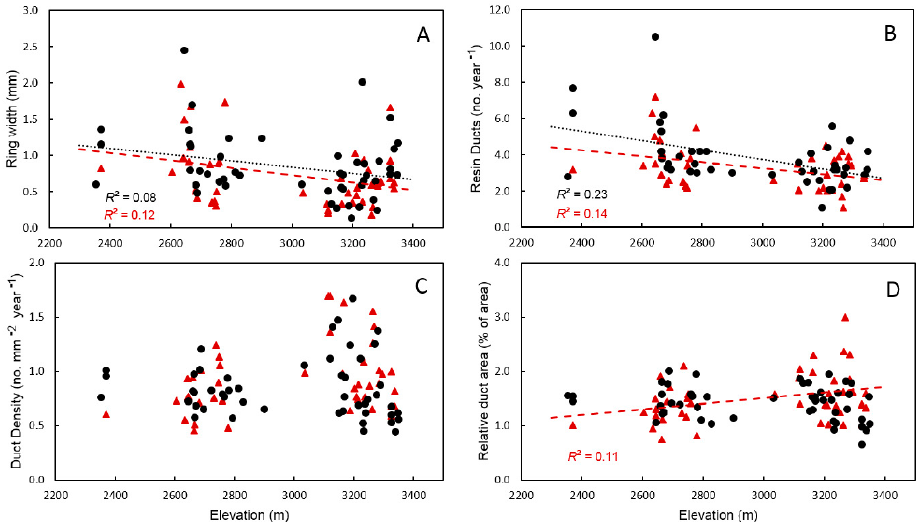
Figure 4. Limber pine vertical resin duct metrics averaged per year for the 10-year interval from 2001 to 2010 as a function of elevation. Radial growth ( A ) and resin duct production ( B ) significantly decreased with increasing source elevation. Duct density ( C ) was not significantly correlated with elevation and only relative duct area ( D ) of susceptible trees was significantly correlated with source elevation. All metrics were calculated using the extracted cores, not the entire tree stem. Symbols are as shown in Figure 3. Black circles are trees inferred in previous studies to carry the dominant Cr4 allele for complete resistance to WPBR; red triangles are for trees that lack the dominant Cr4 allele. Regression lines are shown for those relationships that are significant ( p < 0.05; see Table